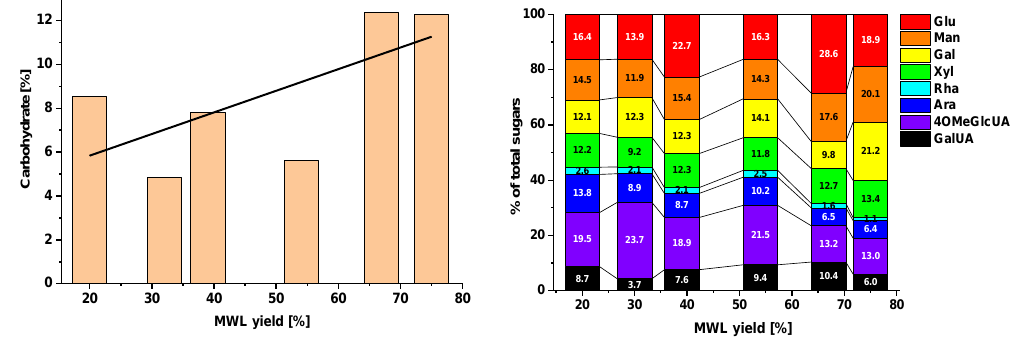
Figure 5. Carbohydrate contents ( left ) and distributions of individual sugars ( right ) depending on the crude MWL yield.